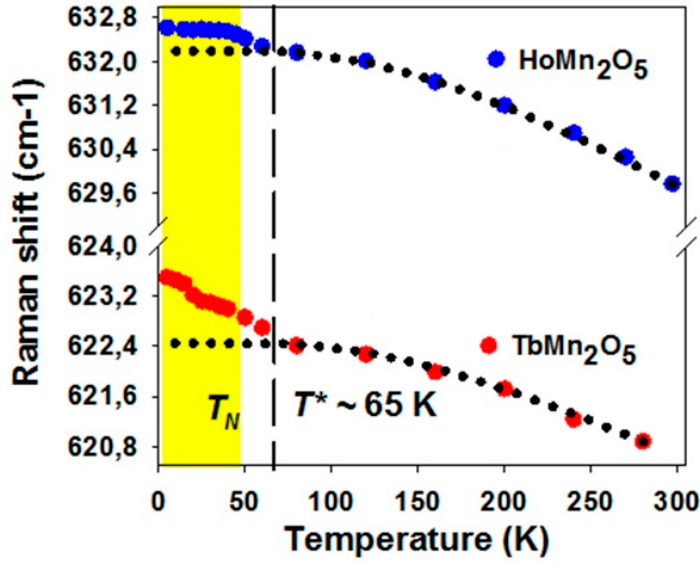
Figure 4. Temperature dependence of the Raman-active phonon ~630 cm − 1 Ag for RMn 2 O 5 (R = Ho, Tb).